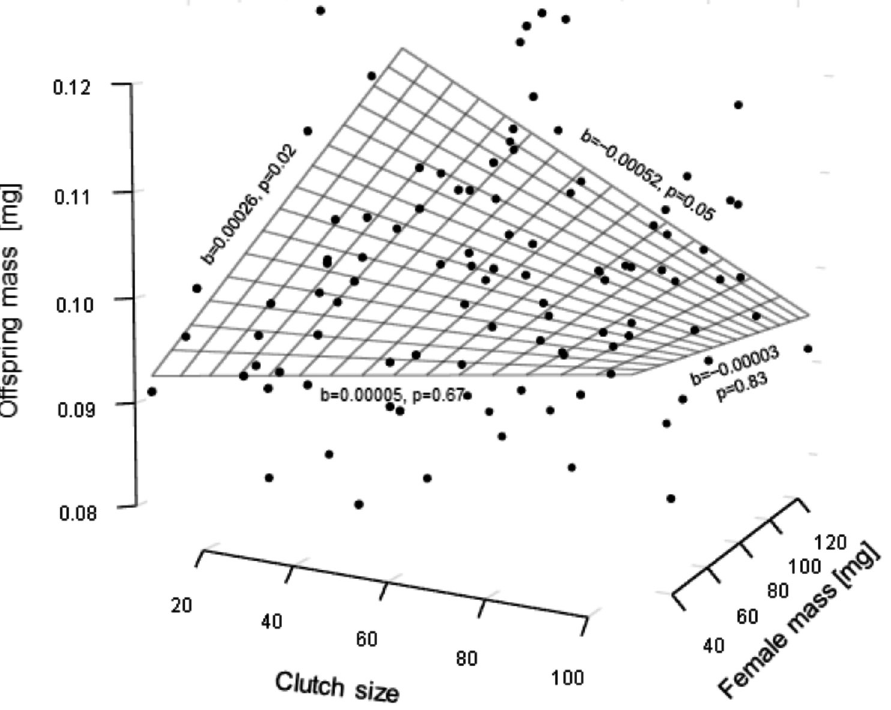
Figure 2. In Porcellio scaber , the heaviest offspring were released by large females that produced small clutches. The plane represents a multiple regression model fitted to the data; the partial slopes depicted on the edges were calculated by setting the other predictor value to its minimum and maximum